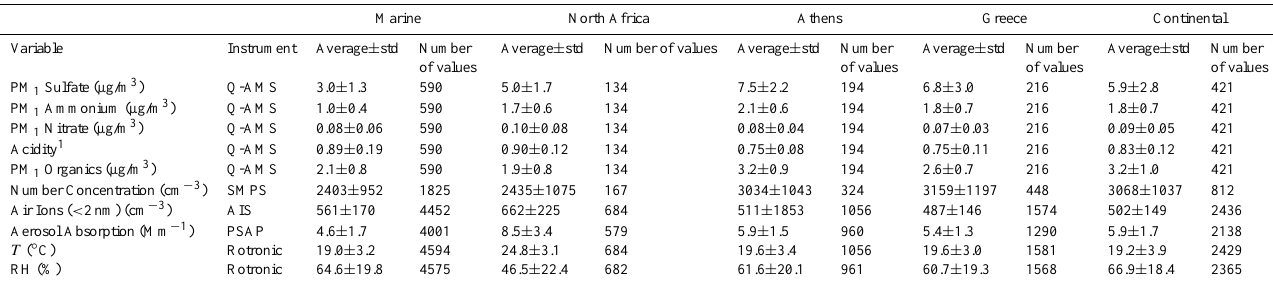
Table 2. Source region analysis for meteorological, physical and chemical properties.